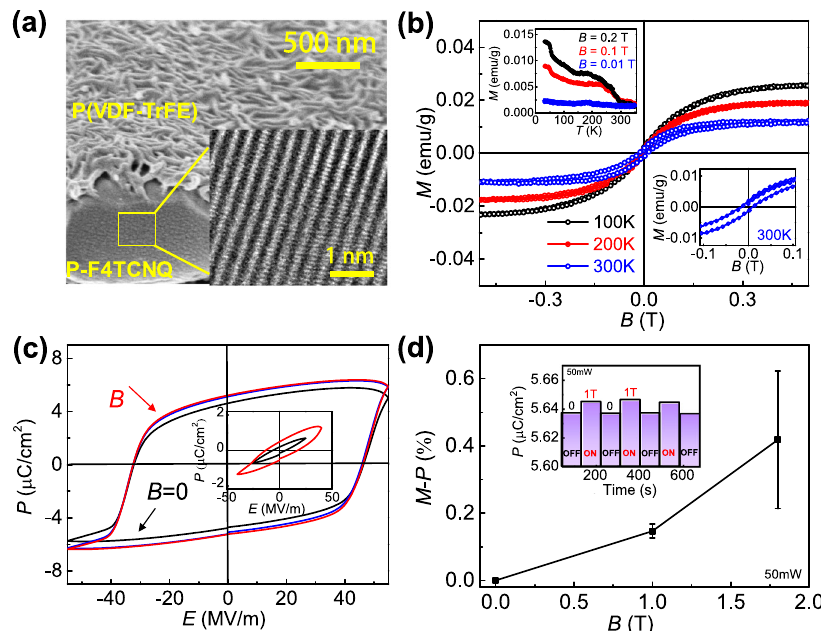
Fig. 1 Ferromagnetic and magnetoelectric coupling. a SEM of the ferromagnetic P-F4TCNQ/ferroelectric P(VDF-TrFE) complexes. The inset shows the HRTEM image of P-F4TCNQ. b M – H loops of ferromagnetic P-F4TCNQ/ferroelectric P(VDF-TrFE) complexes with different temperature. The up inset is the temperature dependence of ferromagnetic magnetization with different applied magnetic fi elds. c P – E loops of ferromagnetic P-F4TCNQ/P(VDF-TrFE) complexes. d Magnetic fi eld-dependent ferroelectric polarization of P-F4TCNQ/P(VDF-TrFE) complexes under light illumination of 50 mW. The ON (OFF) denotes that the external magnetic fi eld is tuned on (off). ´ 100 % . The error bars are standard deviations of the three times. ON/OFF cycles measurements with different magnetic M (cid:1) P ¼ P B ð Þ(cid:1) P B ¼ 0 ð Þ P B ¼ 0 ð Þ fi